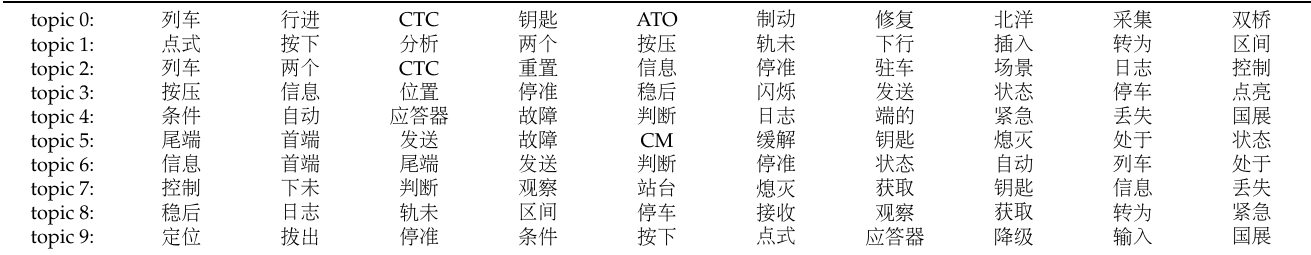
Table A3. Topic analysis of PEC in